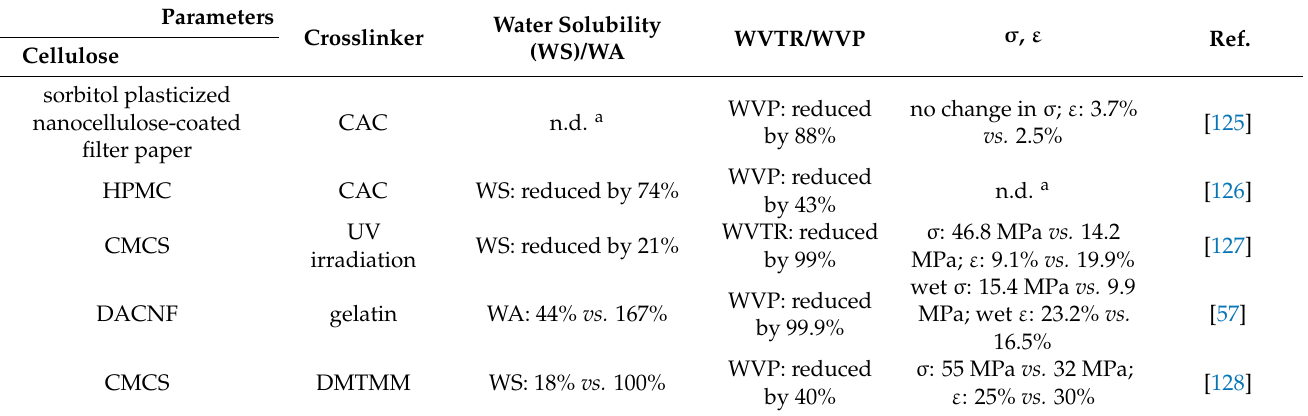
Table 7. Influence of crosslinking on water sensitivity and mechanical strength of cellulose packaging (after vs.